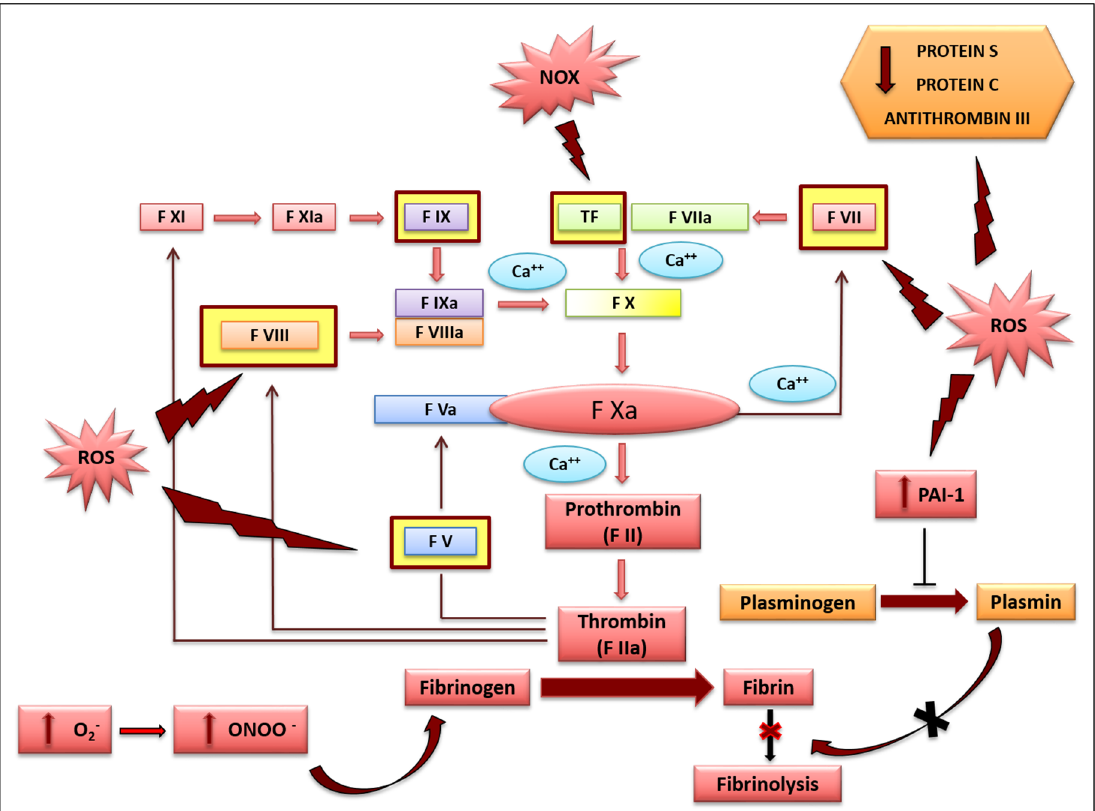
Figure 2. The figure shows ROS and NOX modulation of different phases of secondary hemostasis and fibrinolysis through the upregulation of several proteases and the inhibition of antithrombotic factors in ECs. The imbalance generated between prothrombotic and antithrombotic factors leads to the stabilization of fibrin clot formation with subsequent de- velopment of the atherothrombotic process. ECs: Endothelial Cells; F V; Factor V; F Va; Factor Va; F VII; Factor VII; F VIIa: Factor VIIa; F VIII: Factor VIII; F VIIIa: Factor VIIIa; F IX: Factor IX; F IXa: Factor IXa; F X: Factor X; F Xa: Factor Xa; F XI: Factor XI; F XIa: Factor XIa; PAI-1: Plasminogen Activator Inhibitor-1; ROS: Reactive Oxygen Species; NOX: NADPH oxidase; TF: Tissue Factor.